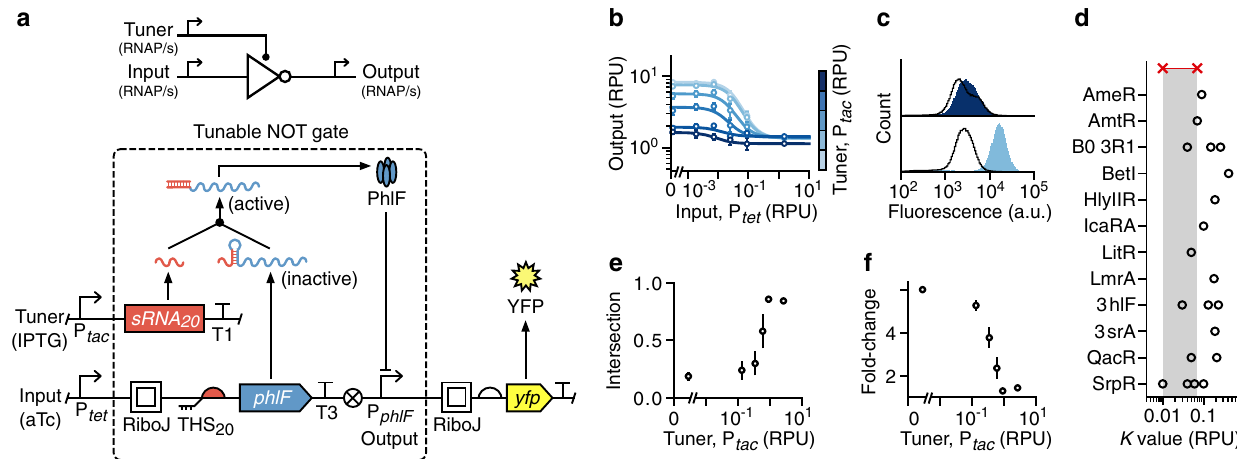
Fig. 2 Design and characterization of a tunable NOT gate. a Schematic of the tunable NOT gate (top) and genetic implementation embedding the TES (bottom, dashed box). Yellow fl uorescent protein (YFP) expression is driven by the output promoter and T1 and T3 correspond to the transcriptional terminators L3S3P11 and ECK120033737, respectively 65 . b Experimentally measured response functions of the tunable NOT gate. Points denote the average of three biological replicates and error bars show ±1 standard deviation. Each line shows a fi tted Hill function for a fi xed tuner input (color scale light – dark: 0.002, 0.03, 0.15, 0.43, 0.9, 2.6 RPU). c Flow cytometry distributions of the output YFP fl uorescence from the tunable NOT gate when the tuner promoter activity is low (bottom; 0.002 RPU) and high (top; 2.6 RPU). Black outlined distributions correspond to a high input promoter activity (1.5 RPU) and the fi lled blue distributions to a low input promoter activity (0.002 RPU). d Comparison of the switching point ( K value) for each repressor-based NOT gate from Cello 7 (black circles) to the range achievable by the tunable NOT gate (red crosses and shaded regions). e Fraction of intersection between output YFP fl uorescence distributions for low (0.002 RPU) and high (1.5 RPU) inputs across varying tuner promoter activities. Points denote the average of three biological replicates and error bars show ±1 standard deviation. f Fold change in the median output YFP fl uorescence between low (0.002 RPU) and high (1.5 RPU) inputs across varying tuner promoter activities. Points denote the average of three biological replicates and error bars show ±1 standard deviation. Source data are available in the Source Data fi